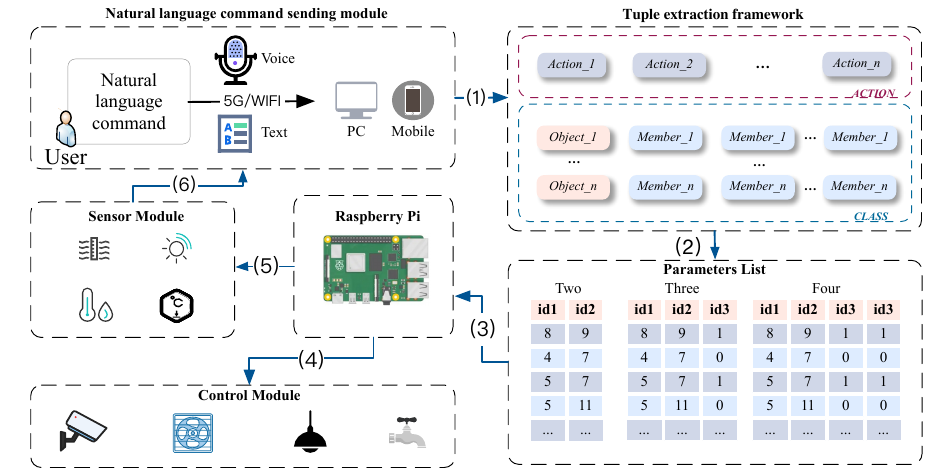
Figure 1. Human–machine interaction abstraction workflow in